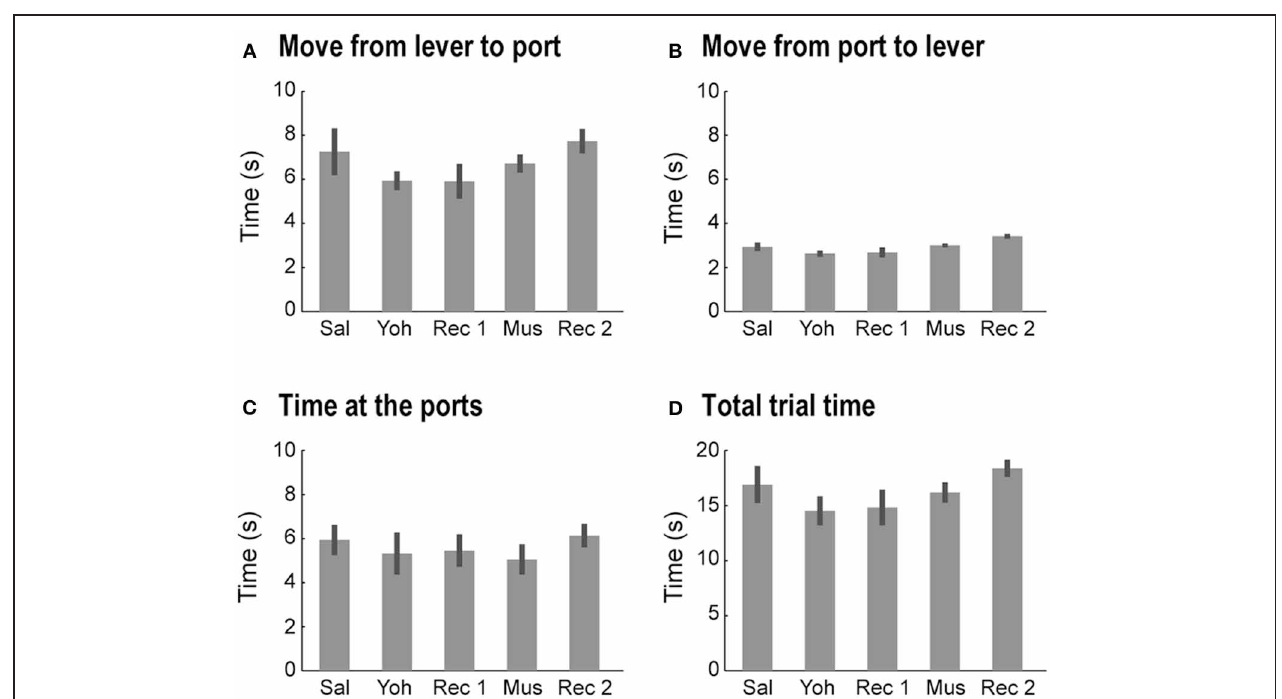
FIGURE 5 | (A) Percent correct trials in the memory-guided (black bars) and stimulus-guided (gray bars) tasks after muscimol infusions (Mus), and in a recovery session (Rec). Error bars are SEM. ∗∗ Denotes p < 0 . 01.